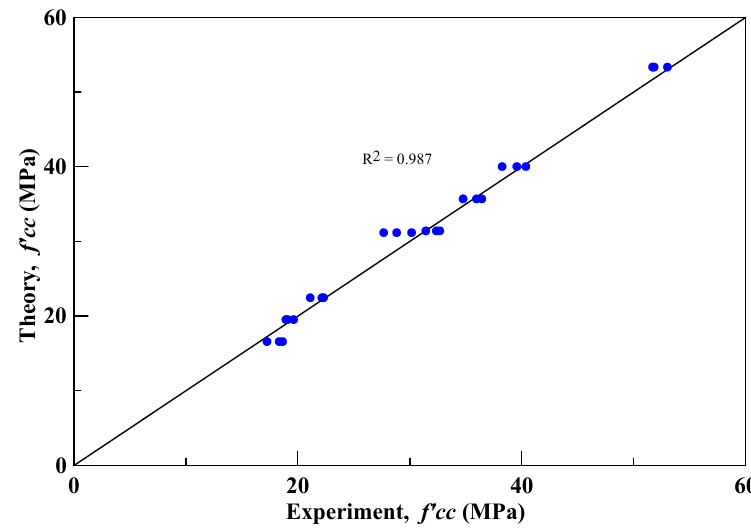
Figure 10. The relationship diagram between the experimental and proposed theoretical strengths. Table 7. The compressive strength error analysis between the experiment and proposed formula.